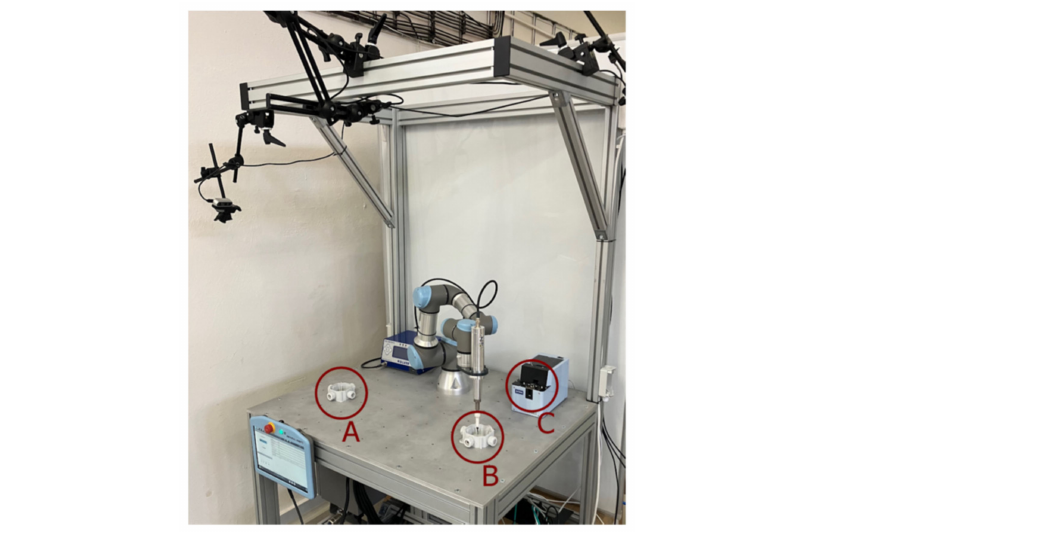
Figure 10. Experimental workplace with the UR3 robot; letters A and B denote the assembly stations, letter C denotes the supply feeder.